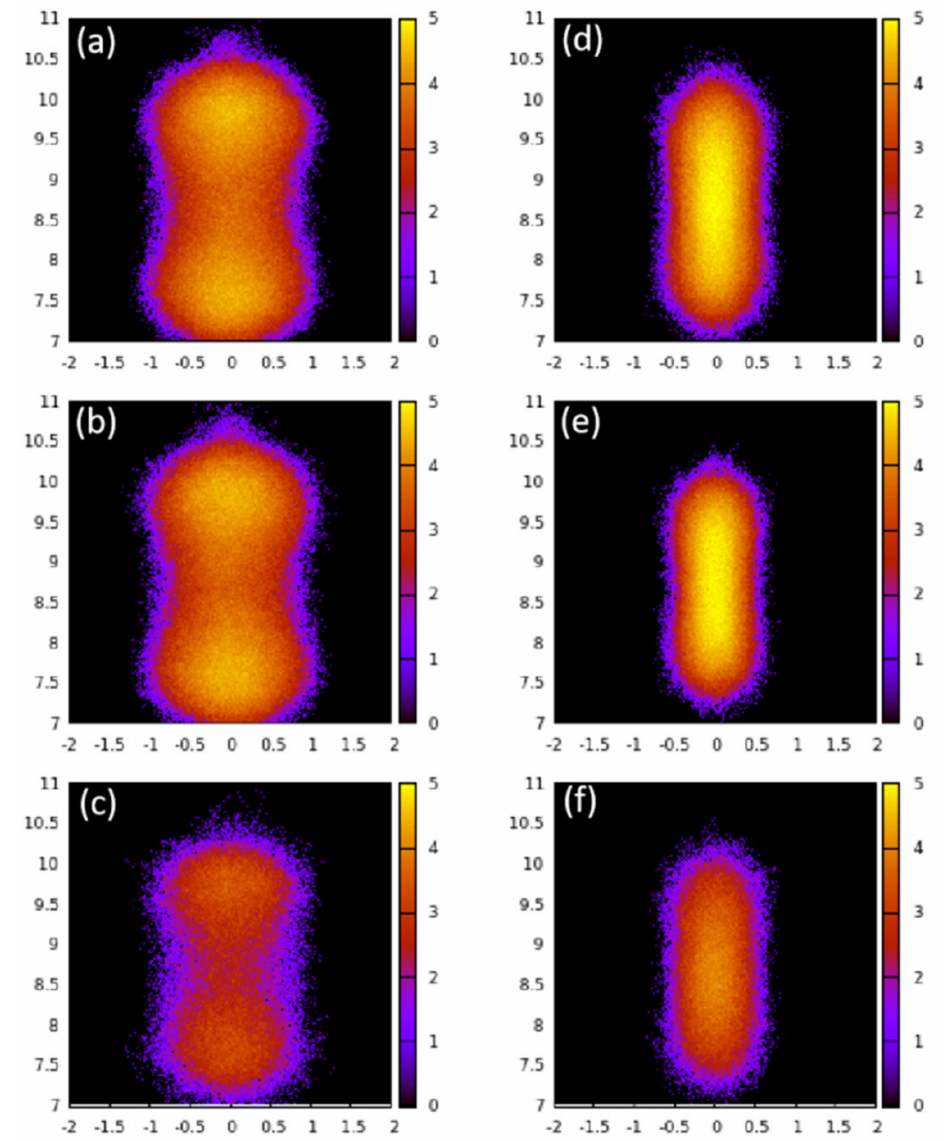
Figure 2. Distribution of guest molecules CO 2 ( a – c ) and ethane ( d – f ) in a pore of ZSM-22 at the guest loadings of 72 ( a , d ), 52 ( b , e ), and 24 ( c , f ) molecules in the simulation cell. The intensity represents the logarithm of the number of times a guest molecule is found at a position with the given